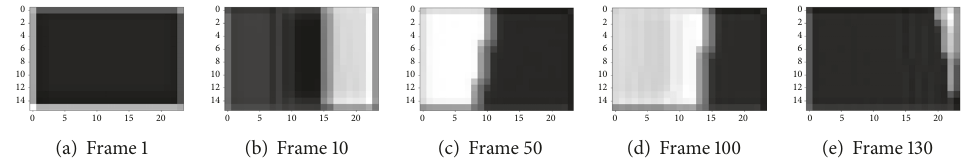
Figure 5: Image generated from the 1 st 𝐺𝑈 output (Layer 1), 𝜏 = 1.0 .